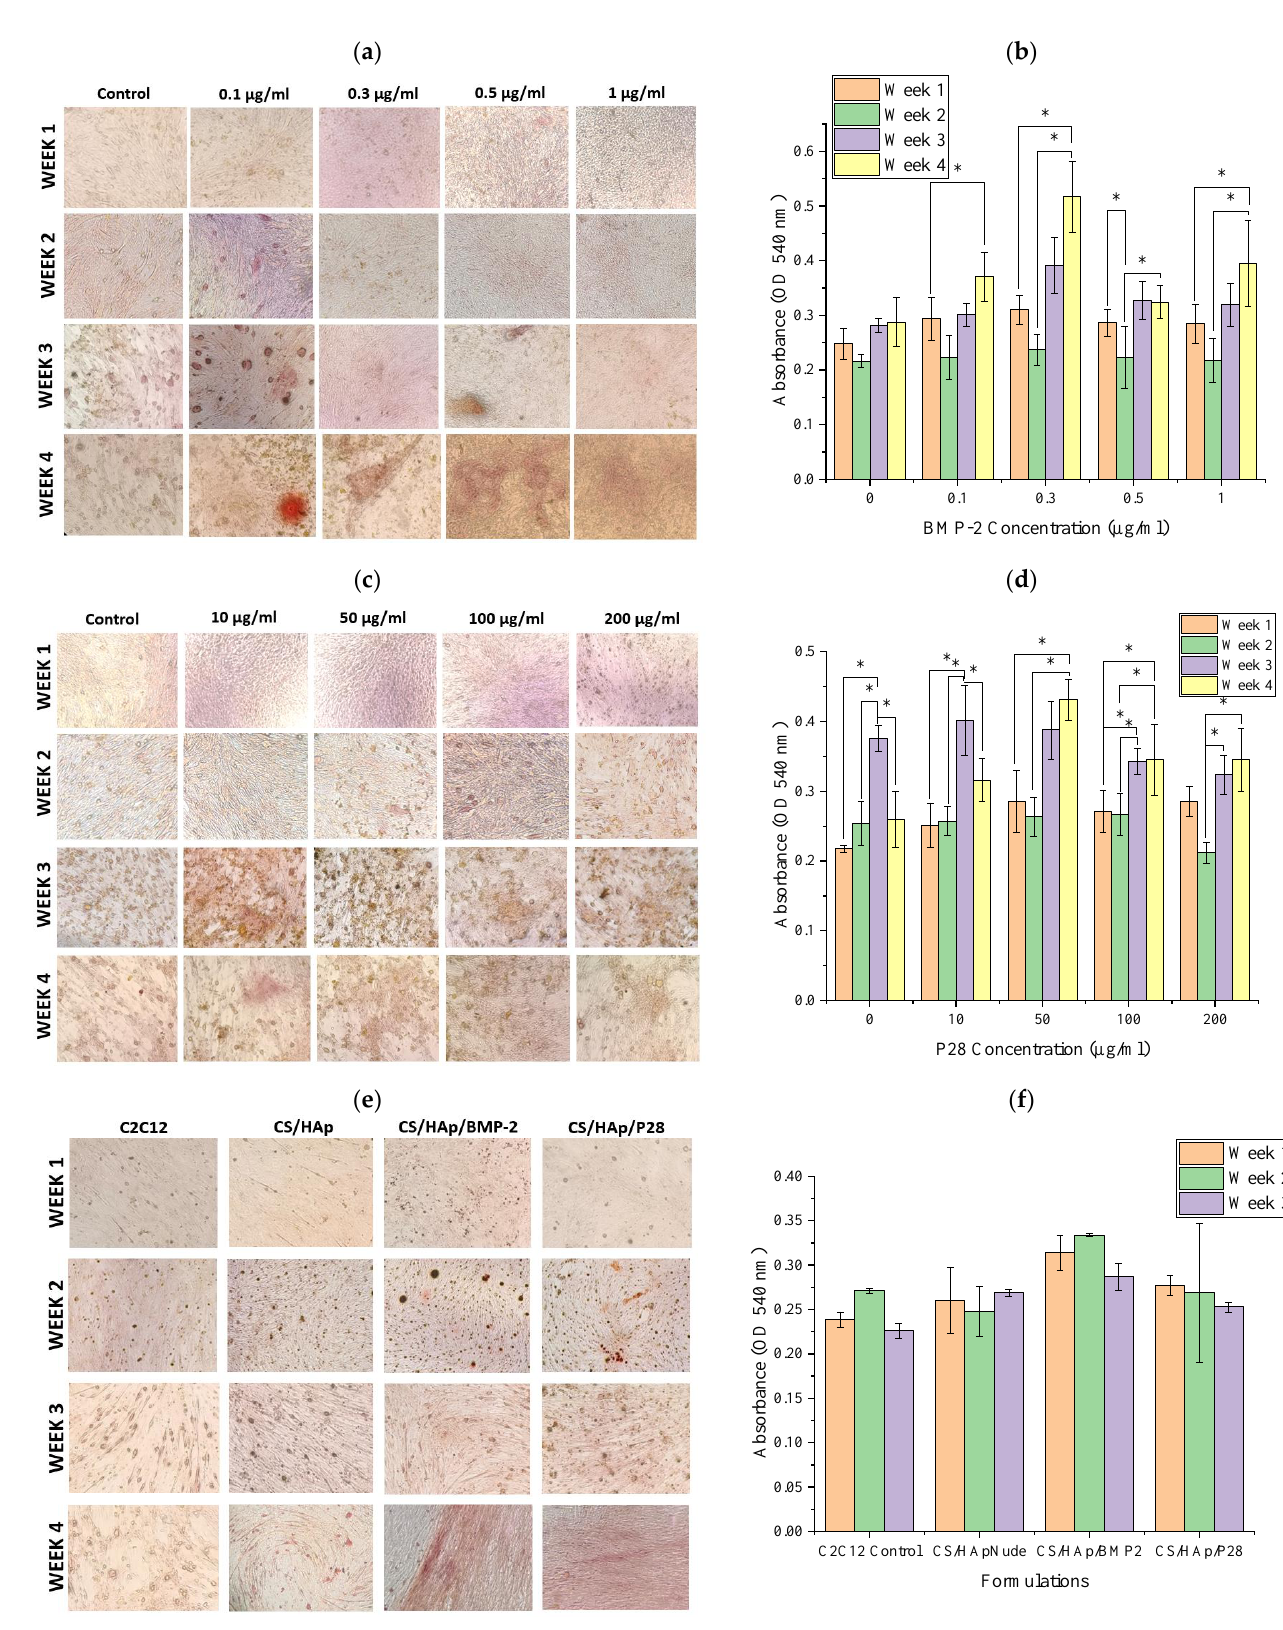
Figure 5. Alizarin red stained images and the destaining by CPC quantitation. ( a ) ARS of C2C12 treated with various concentrations of BMP-2. ( b ) CPC quantitation of the destained ARS of C2C12 treated with various concentrations of BMP-2. ( c ) ARS of C2C12 treated with various concentrations of P28. ( d ) CPC quantitation of the destained ARS of C2C12 treated with various concentrations of